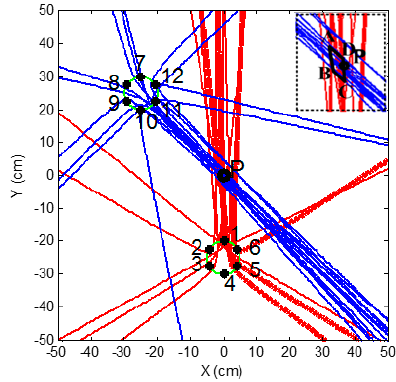
Figure 10. Localization results using the optimized method.